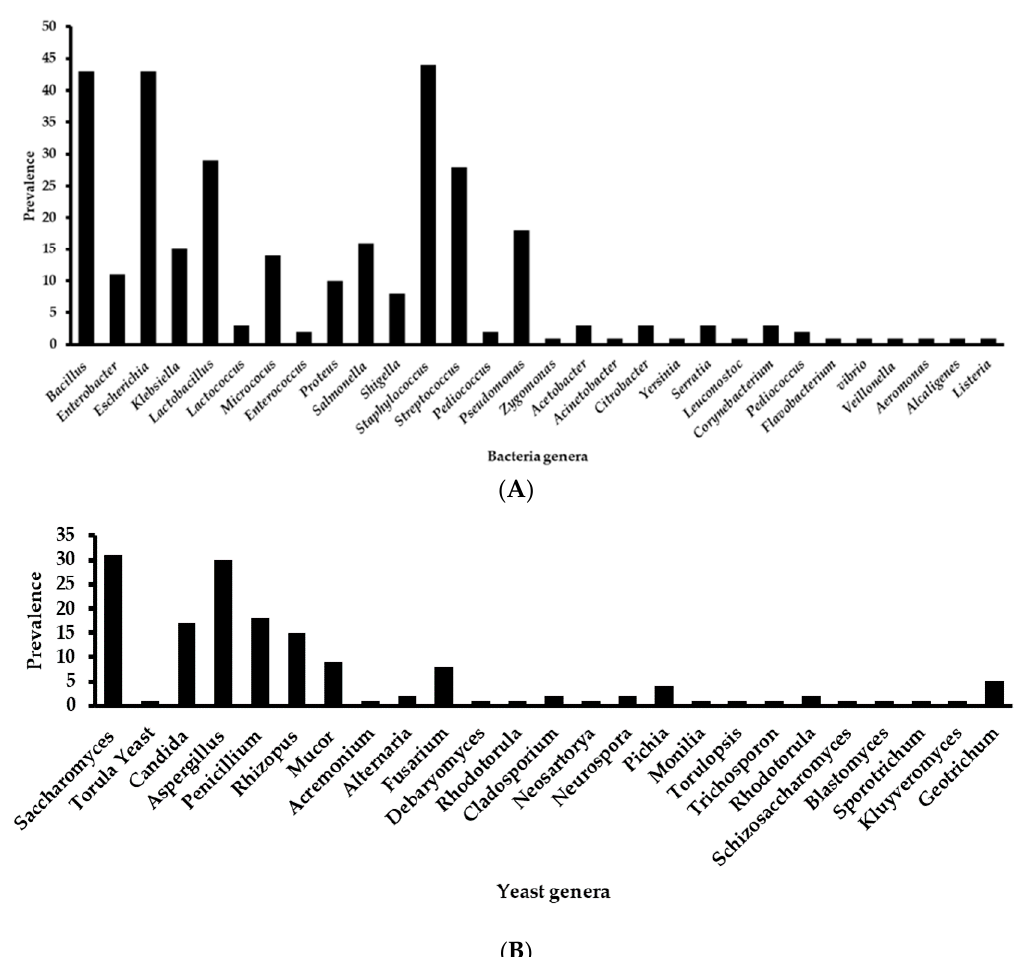
Figure 4. Summary of 30 bacteria ( A ) and 25 yeast ( B ) genera associated with nine local beverages reported in 90 articles. The most commonly reported species for bacteria, yeast and filamentous fungi are Staphylococcus , Saccharomyces and Aspergillus , respectively. Overall prevalence was calculated as the actual number of times a genus was isolated across the 90 studies.